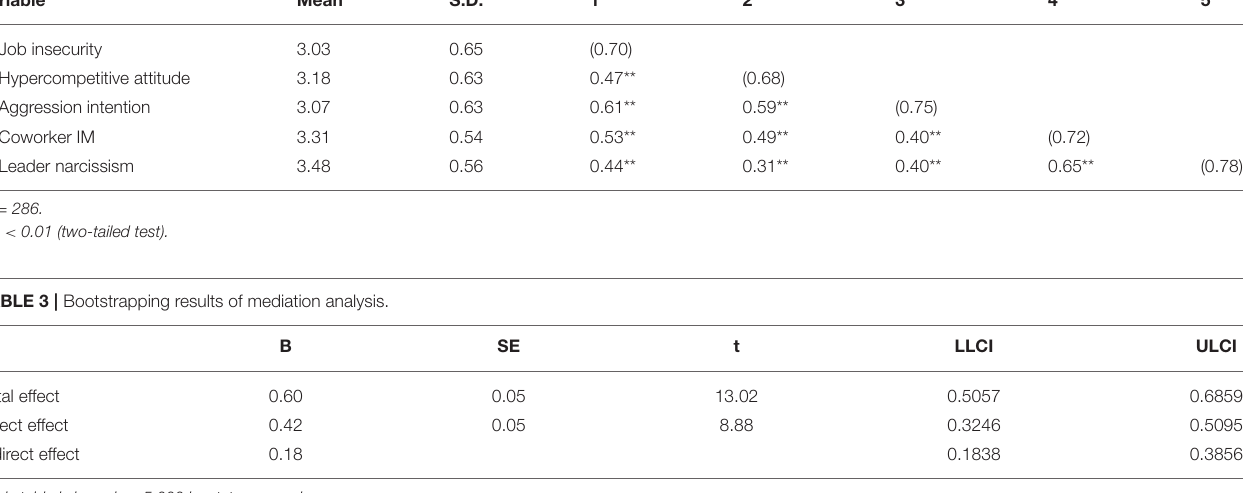
TABLE 2 | Descriptive statistics and correlations of variables with internal consistency reliabilities. Variable